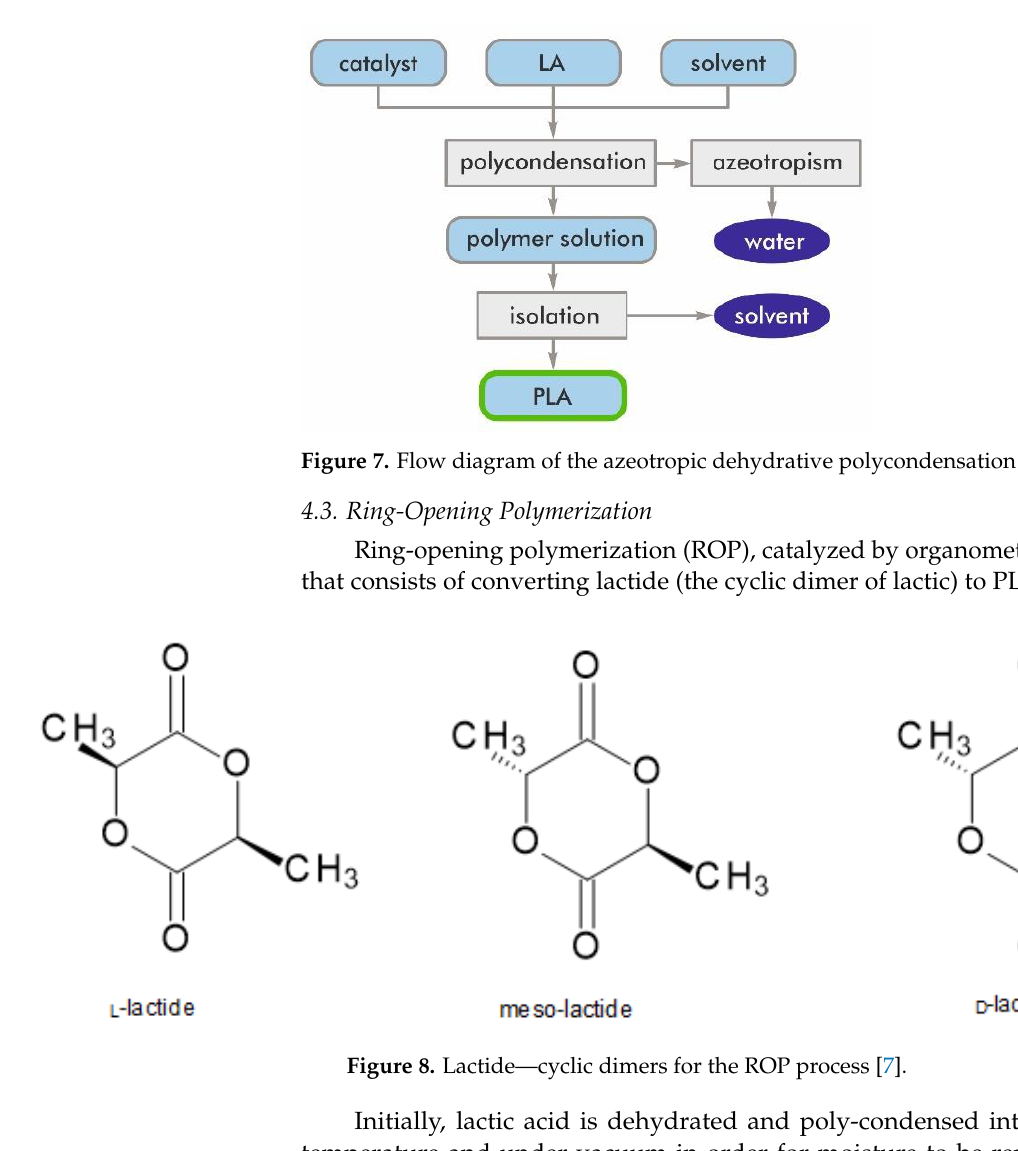
Figure 8. Lactide—cyclic dimers for the ROP process [7].